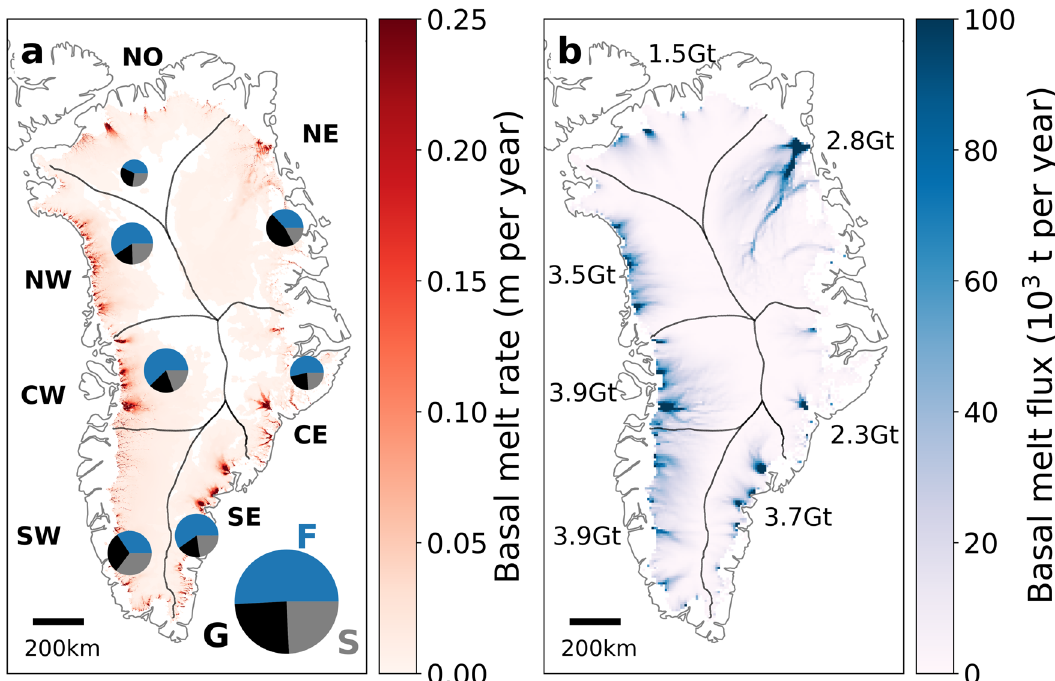
Fig. 2 Total basal melt rates and the resulting fl ux. a Basal melt rates. Pie charts show the contribution from the different heat terms: friction heat (F, blue), geothermal fl ux (G, black) and viscous heat dissipation from surface melt water (S, grey). Size of circles indicate the total basal melt discharge from each sector. b Flux of basal melt water. Numbers show the total basal melt discharge for each